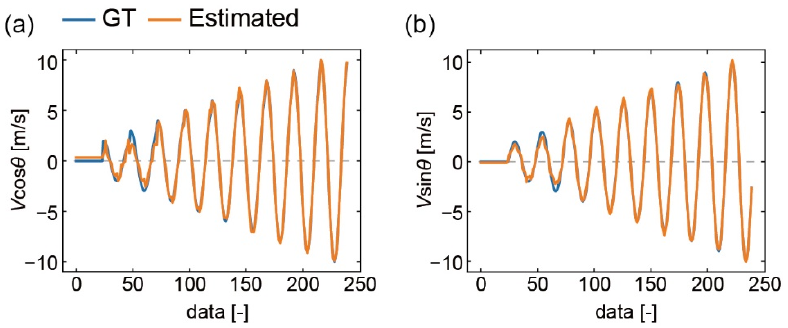
Figure 9. Results of converting the output of the three DP sensors to ( a ) V · cos θ and ( b ) V · sin θ using a regression model. “Data” refers to the data obtained by arranging the sensor voltage values from the wind tunnel experiment in ascending order of wind velocity, calculating the average of 30 measurements at the same angle within the same wind velocity, and arranging them in ascending order of the wind direction.